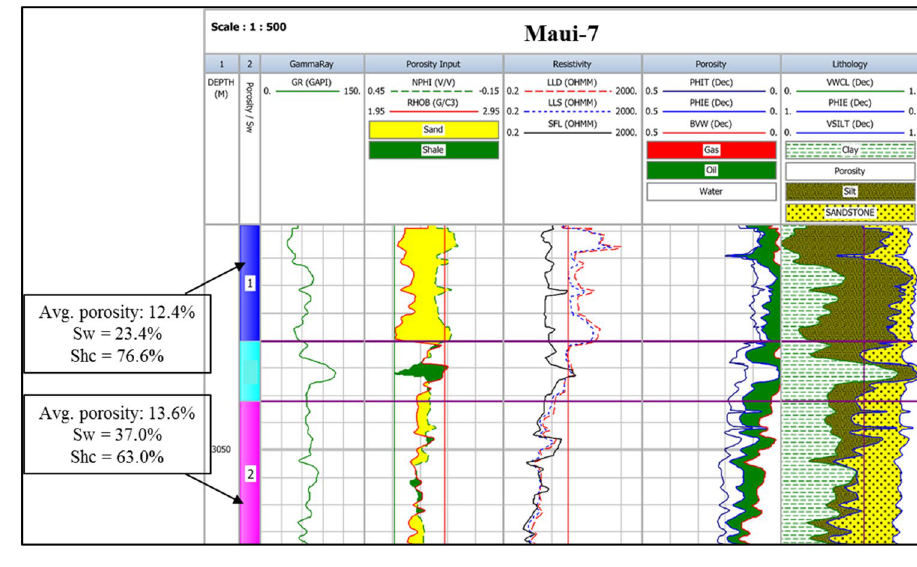
Fig. 15 Well log interpretation of MB-P(8), displaying three potential hydrocarbon-bearing zones with Zone 1 as the most promising